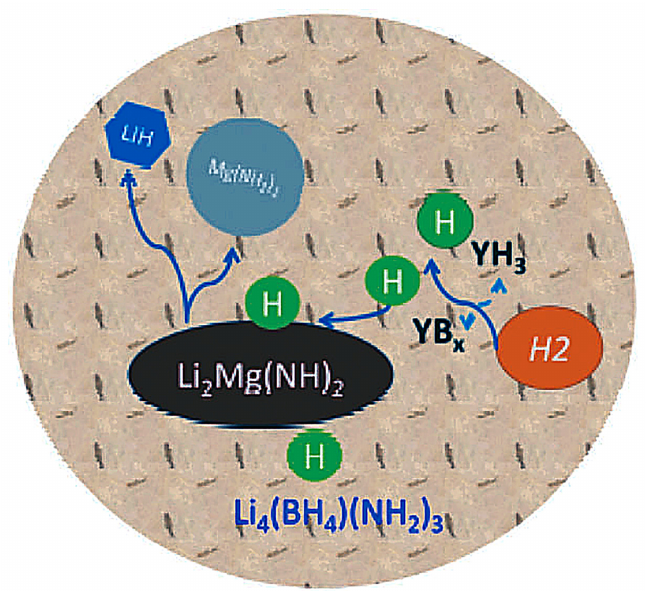
Figure 15. The proposed absorption reaction mechanism of the co-added sample. Figure is reprinted with permission from ref. [177] .